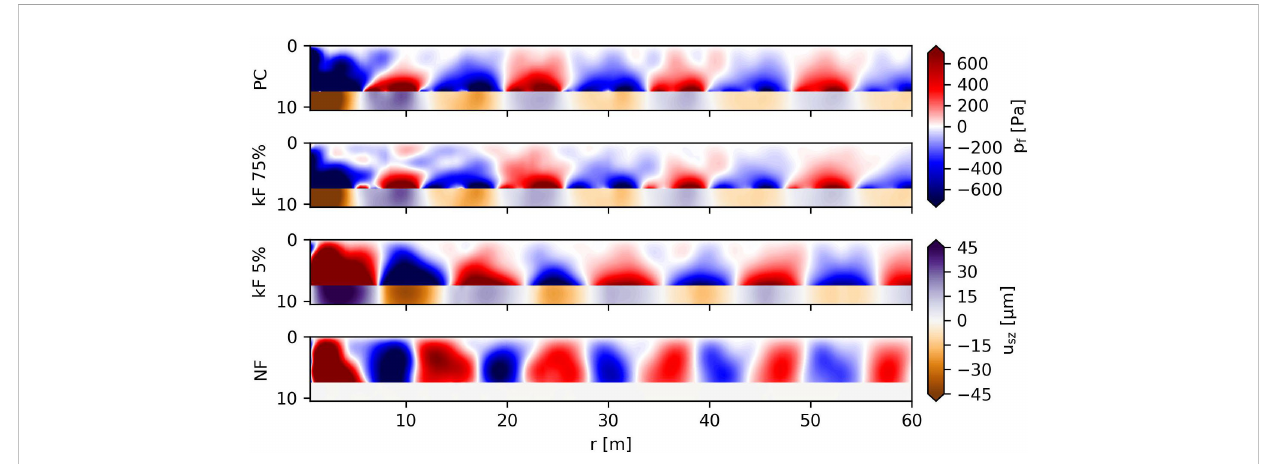
FIGURE 9 Snapshot of the time domain pressure fi eld for the periodic force for varying interface conditions.